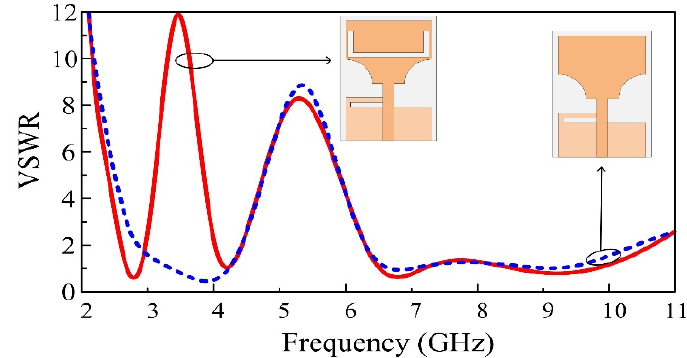
Figure 5. Comparison of single notch and dual notch UWB antennas.